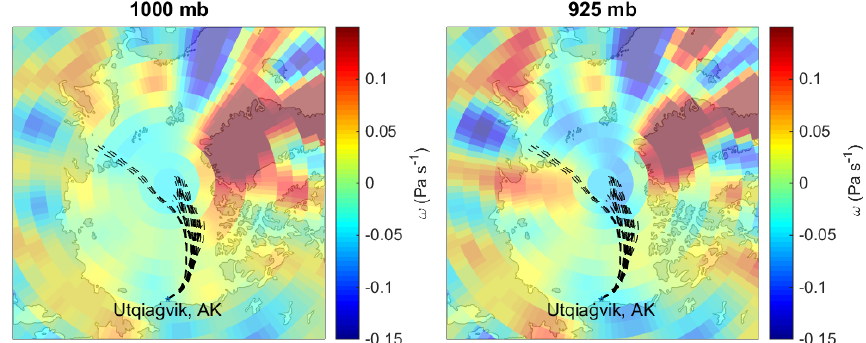
Figure 6. HYSPLIT backward air mass trajectories for the plume overlaid on daily averaged NCEP reanalysis data for 11 March 2012. All panels show an ensemble of 27 72h trajectories arriving at Utqia˙gvik on 13 March 2012 at noon local time. The central trajectory had an arrival height of 750m. The ensemble is generated by offsetting the modeled meteorology used to calculate the trajectory by 1 ◦ horizontally and ∼ 250m vertically prior to running HYSPLIT. The blue regions on the map reflect regions where air was moving upward, while red regions reflect regions where air was moving